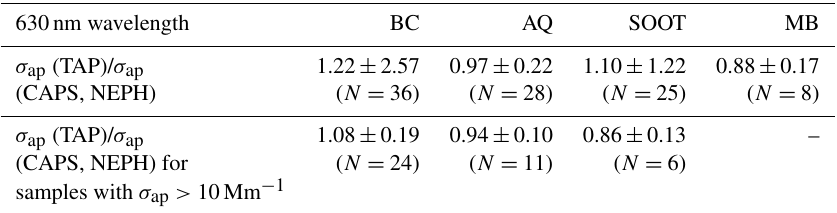
Table 5. Ensemble-average ratios of σ ap (TAP)/ σ ap (CAPS, NEPH) at 630nm wavelength. N denotes the number of experiments used for the average.